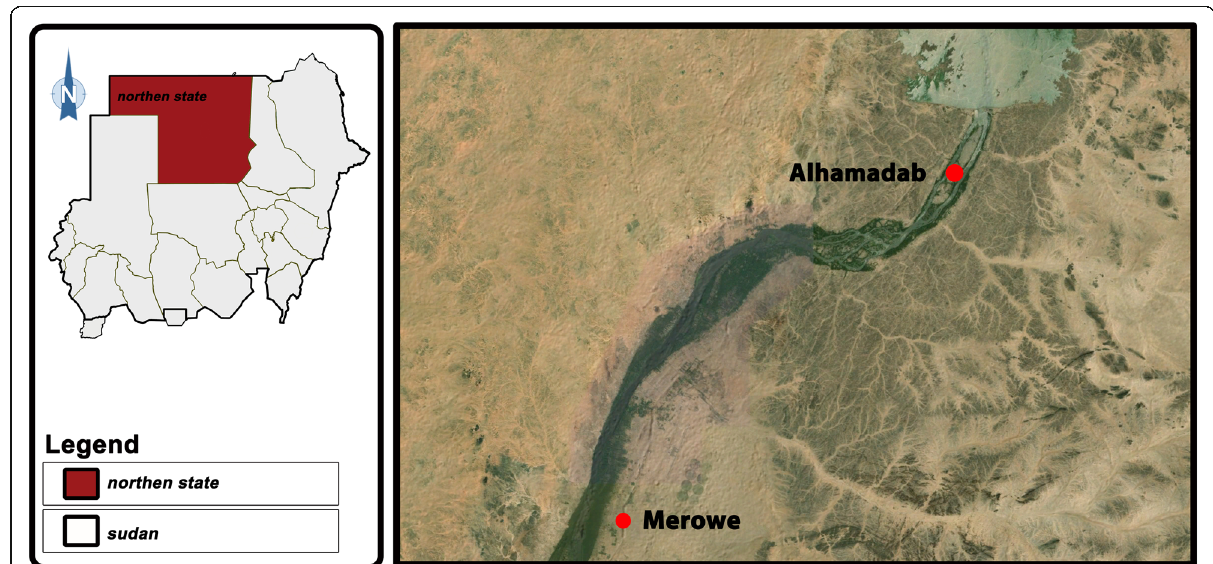
Fig. 1 Map of the location of the study area in north Sudan state. Sudan map including urban site (Merowe) and rural site